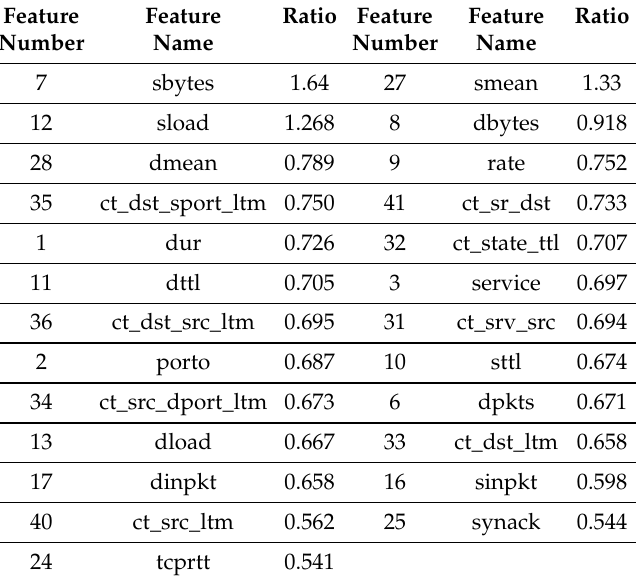
Table 3. Information gain ratio for different features on UNSW-NB15